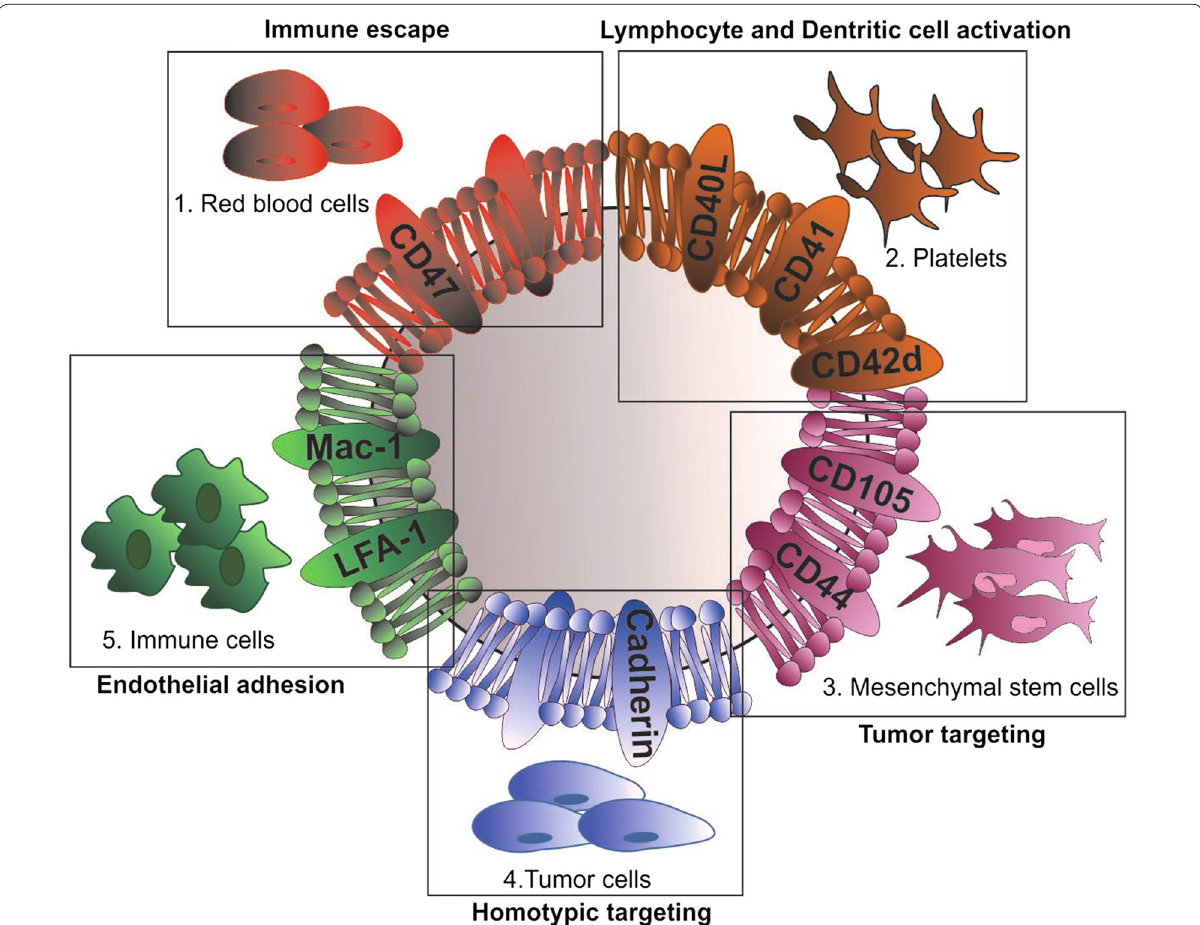
Fig. 1 Schematic illustration of an empty biomimetic nanoparticle (NP) developed from the membrane sourced of different cells: platelets, red blood, mesenchymal, tumor and immune cells. Thanks to the cells of origin, NPs are endowed with specific features (in bold) that mediate their ability to escape the immune system, extravasate blood vessels and target tumor site. LFA-1 lymphocyte function-associated antigen 1, Mac-1 macrophage-1 antigen, CD Cluster of